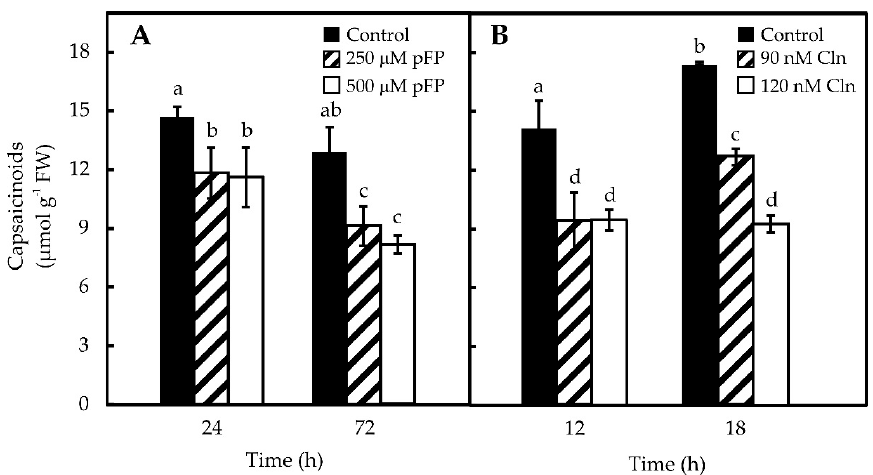
Figure 5. Effect of inhibition of Phe ( A ) and Val ( B ) synthesis on CAP contents in pepper placentas maintained in vitro. Data represent mean ± standard deviation (S.D.) of three independent experiments with three replicates. Bars labeled with different letters are significantly different (Tukey’s test, α = 0.05).